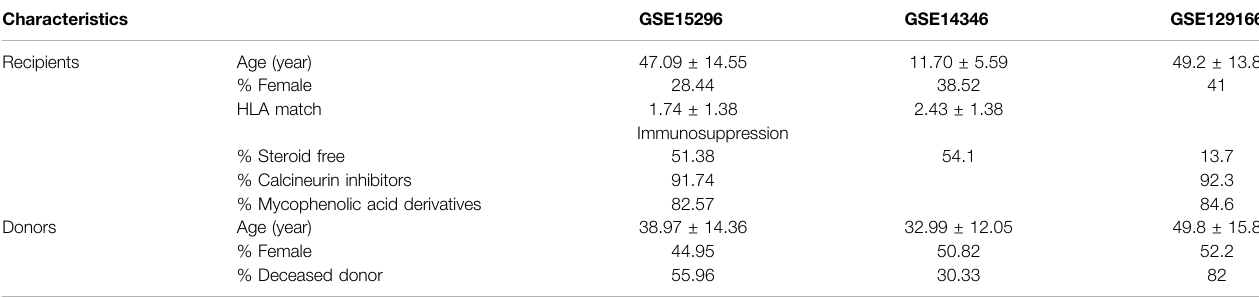
TABLE 1 | Characteristics of three transplantation cohorts included in the current study. Characteristics